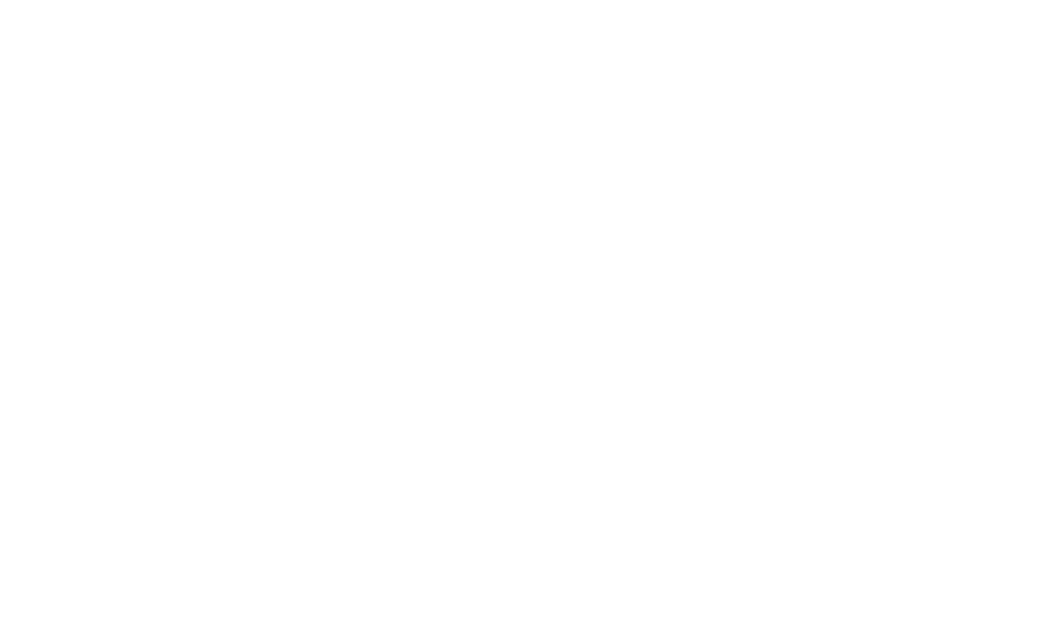
Figure 7. The CLSM images of the drug loaded nanocarriers-coated with leaf extracts treated with MCF-7 cell lines. The used concentration of the nanoparticles: 17.5